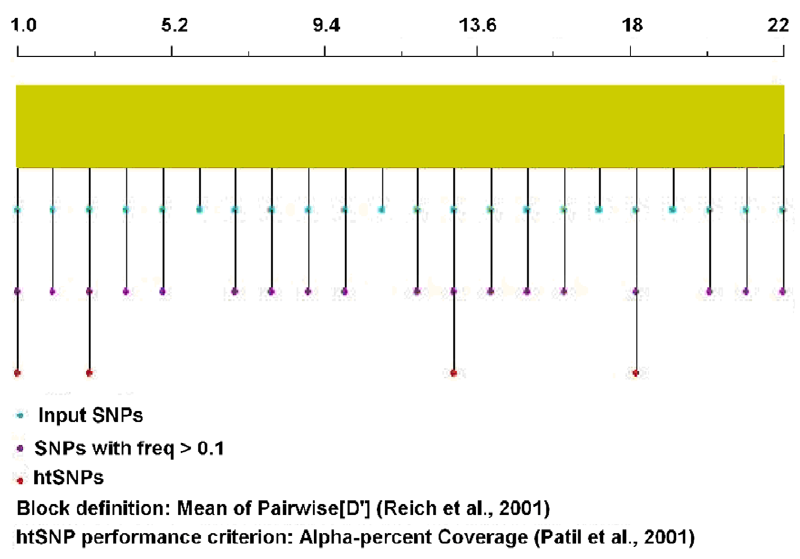
Figure 2. Construction of haplotype and tagging SNPs selection in HSPA8 gene. A total of 22 single nucleotide polymorphisms (SNPs) were analyzed by htSNPer1.0 software to select tagSNPs. 1.0 indicated rs2236660 and 22.0, the last SNP rs4802. The results showed that rs2236660, rs2236658, rs10892958 and rs1461496 were selected for tagSNPs.